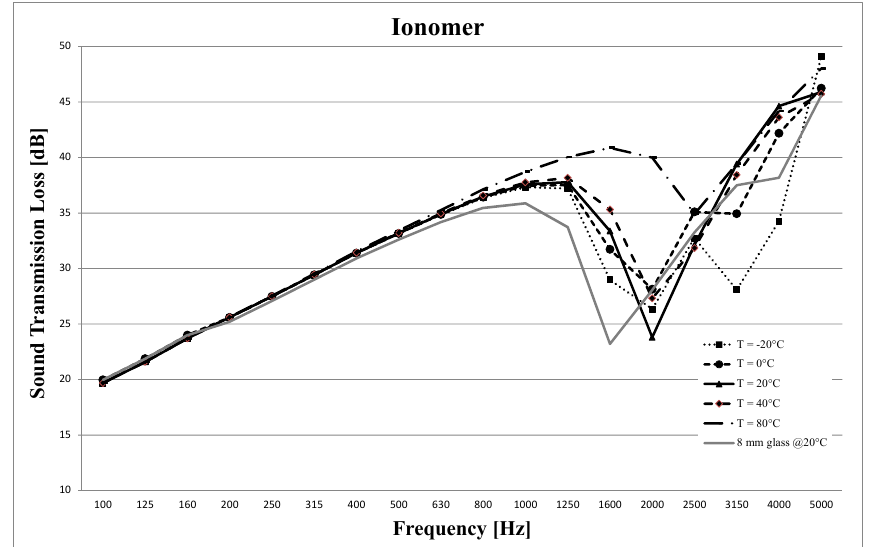
Fig. 18 Sound Transmission Loss Curves of glasses laminated with Ionomer at different temperatures